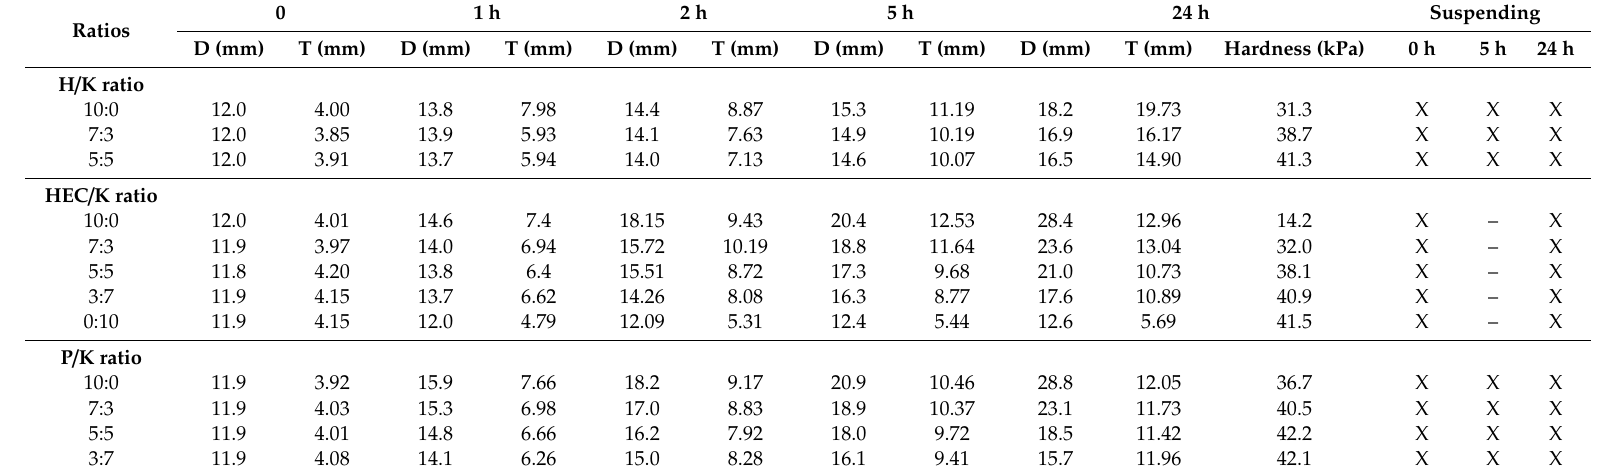
Table 4. Swelling and floating abilities of three polymers (HPMC 90SH 100K, HEC 250HHX, and PEO7000K) with various ratios of Kollidon SR tableted at 1.0 ton of compression